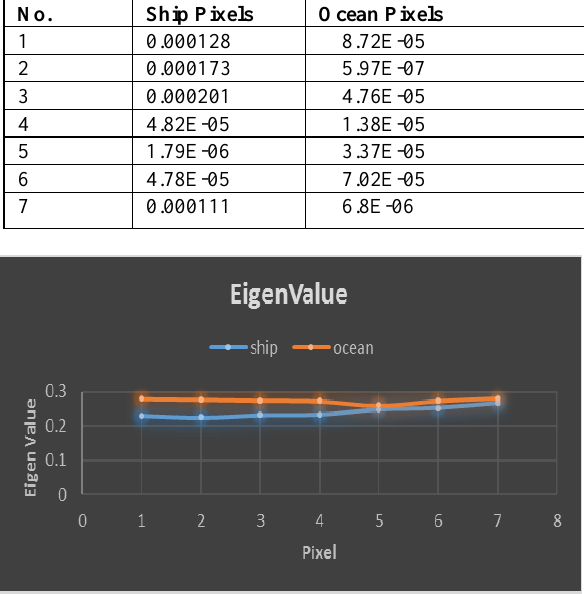
Fig. 8 ALOS1 Ship and ocean pixels [Eigenvalue] analysis